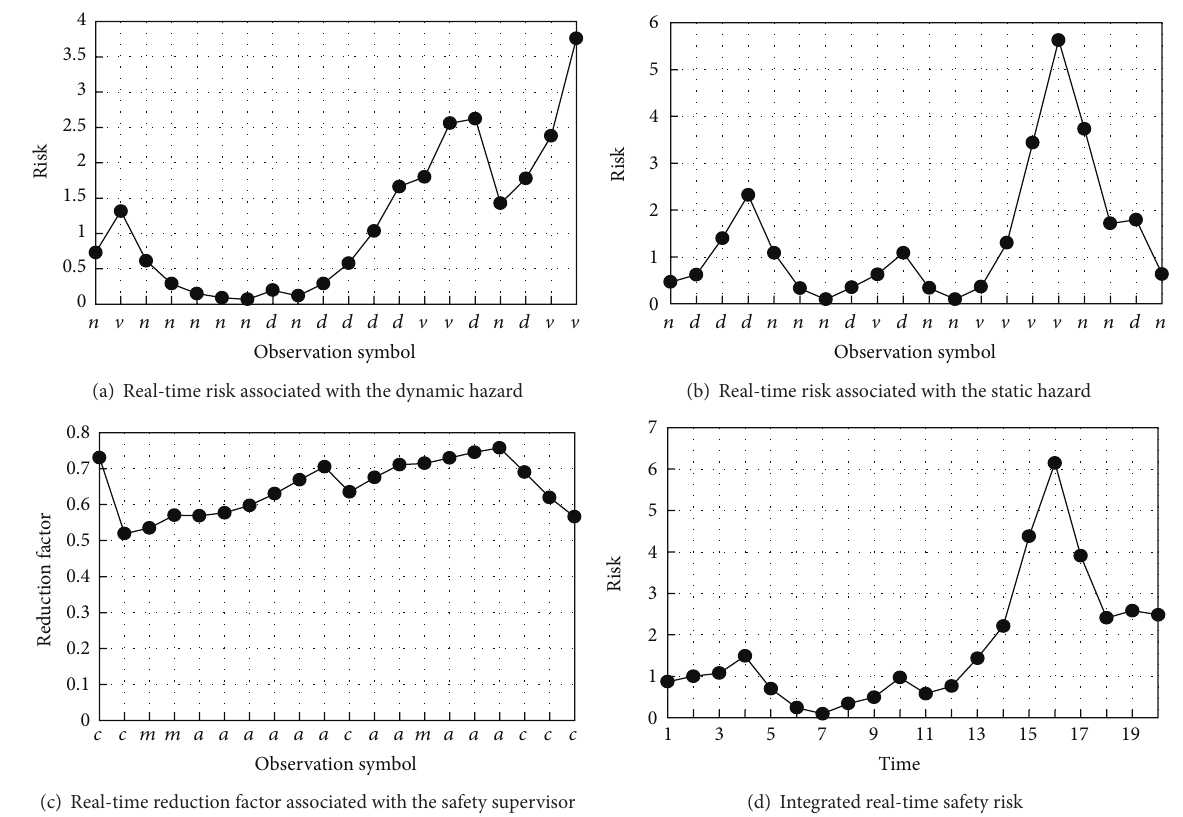
Figure 6: Simulated calculation results illustrating worker safety